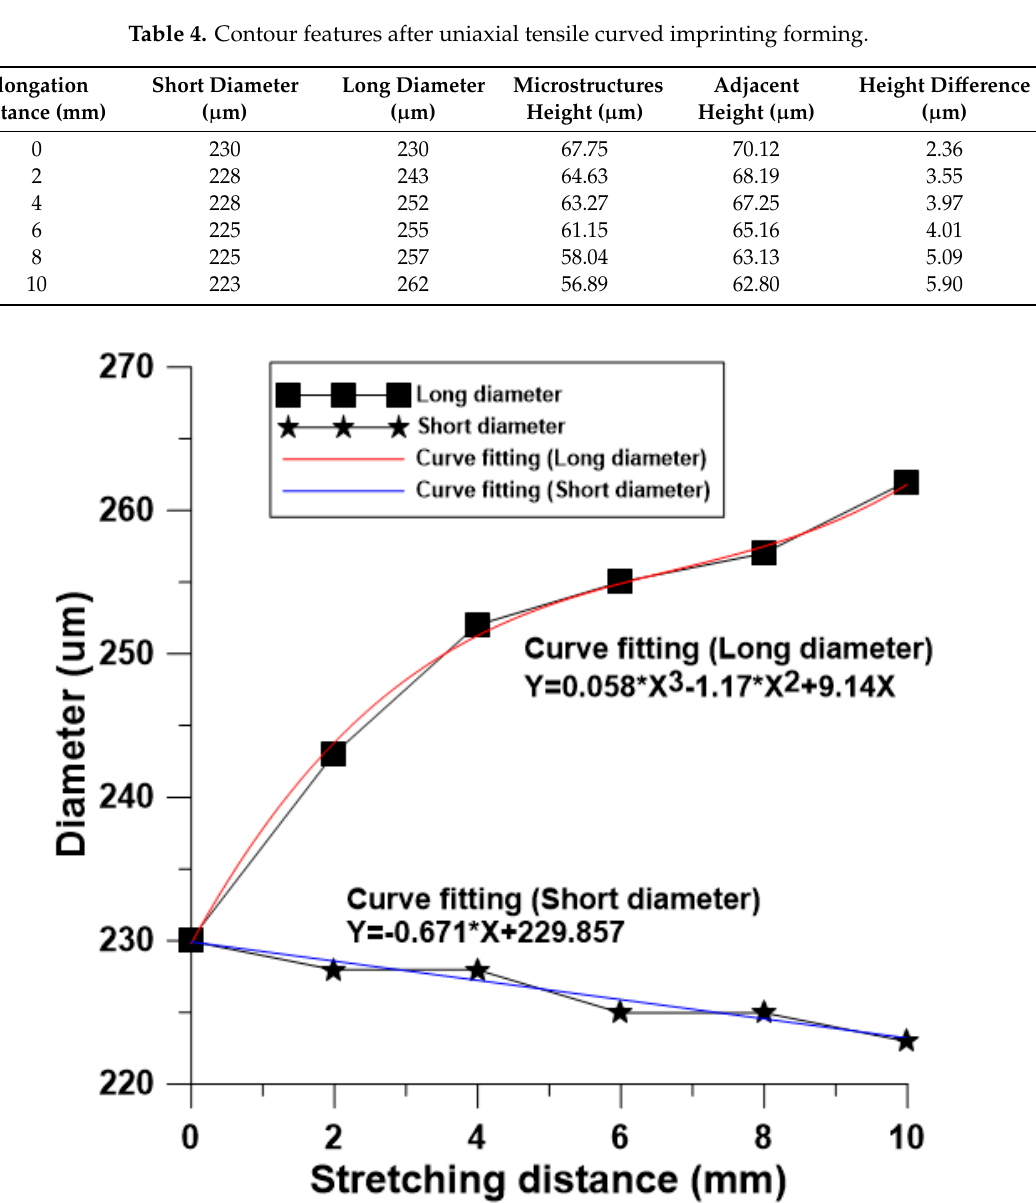
Figure 16. Influence of surface imprinting dynamically controlled uniaxial tensile on microstructure form diameter.